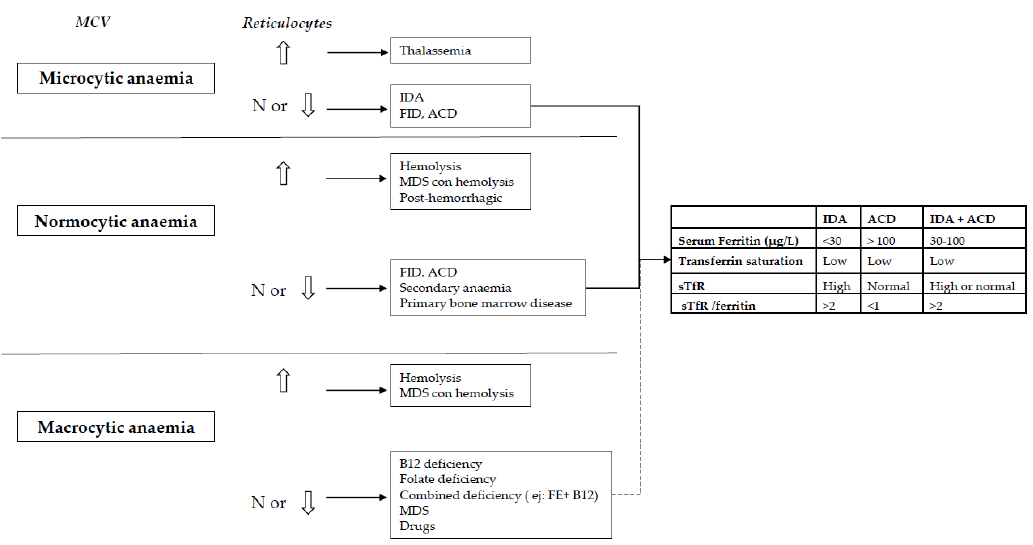
Figure 1. Diagnosis of types of anaemia. MCV: mean corpuscular volume, N: normal, IDA: iron deficiency anaemia, FID: functional iron deficiency, ACD: anaemia of chronic disease, MDS: myelodysplastic syndrome, sTfR: soluble transferrin receptor.